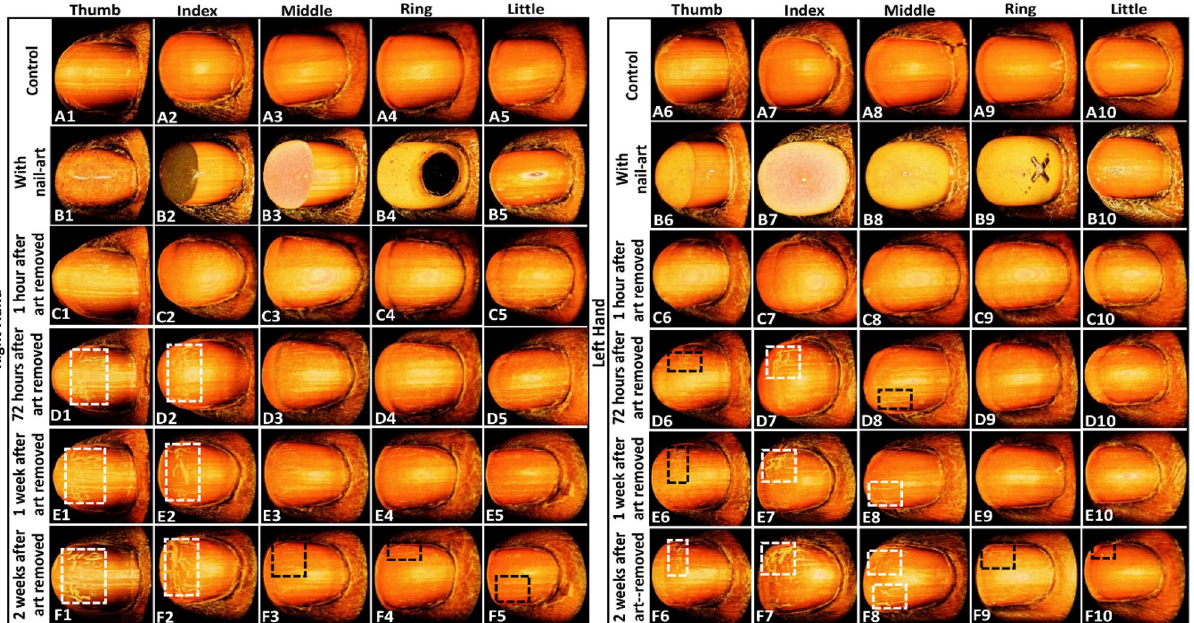
Figure 6. Fingernails 3D images. Images ( A1 – A10 ) 3D images of control fingernails of right and left hands. Images ( B1 – B10 ) 3D images of right and left hands fingernails with nail-art. Images ( C1 - C10 ) 3D images of right and left hands fingernails after 1 h of nail-art removal. Images ( D1 – D10 ) 3D images of right and left hands fingernails after 72 h of nail-art removal. Images ( E1 – E10 ) 3D images of right and left hands fingernails after 1 week of nail-art removal. Images ( F1 – F10 ) 3D images of right and left hands fingernails after 2 weeks of nail- art